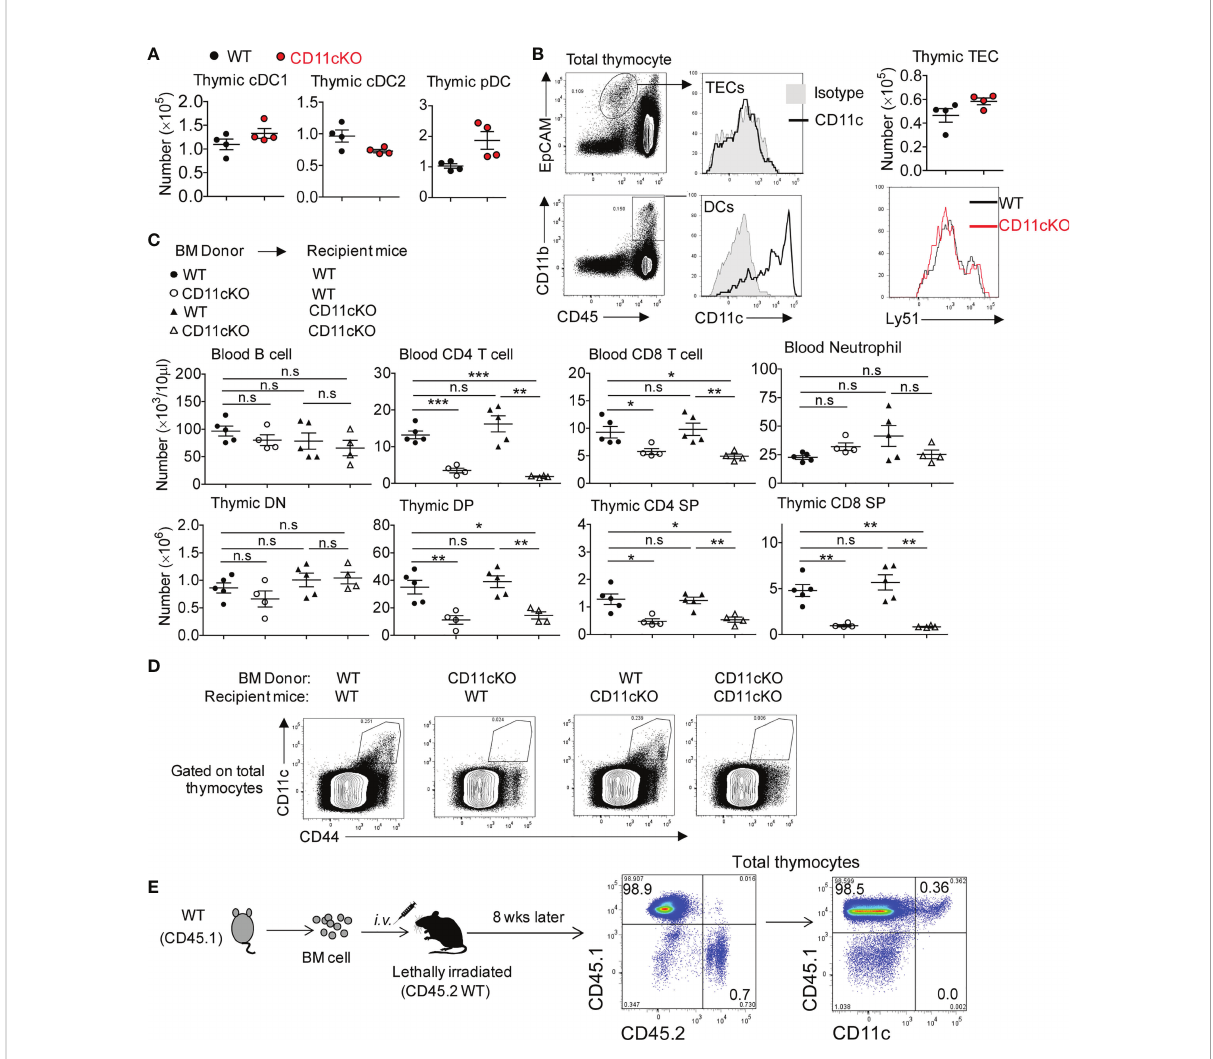
FIGURE 3 The role of CD11c in irradiation-sensitive hematopoietic cells in thymus. (A) thymic DC subset cell counting. cDC1 was gated as MHC- II + XCR1 + CD8a + , cDC2 as MHC-II + XCR1 - CD8a - SIRP a + CD11b + , and pDC as PDCA + CD11b - Ly6C + . Gating strategy could be found in Supplement Figure 1. (B) Left panel: representative FACS data showing CD11c expression pattern; Right-up panel: thymic TECs counting; Right- bottom panel: Ly-51 staining overlay analysis of TECs. (C) Blood (up panel) and thymic (bottom panel) analysis of bone marrow chimeric mice. (D) Representative FACS data showing CD11c expression pattern in thymocytes of chimeric mice described in (C) . (E) Representative FACS data showing CD11c expression pattern in thymocytes of chimeric mice by transferring CD45.1 WT bone marrow cells into lethally irradiated CD45.2 WT recipient mice. Each symbol represents an individual mouse. Experiments were repeated at least 3 times with the same pattern. (A, B) , Student t test was used for statistical analysis; (C) One-way ANOVA with Bonferroni post hoc analysis was performed. *p < 0.05, **p < 0.01, ***p < 0.001. n.s., no signi fi cant